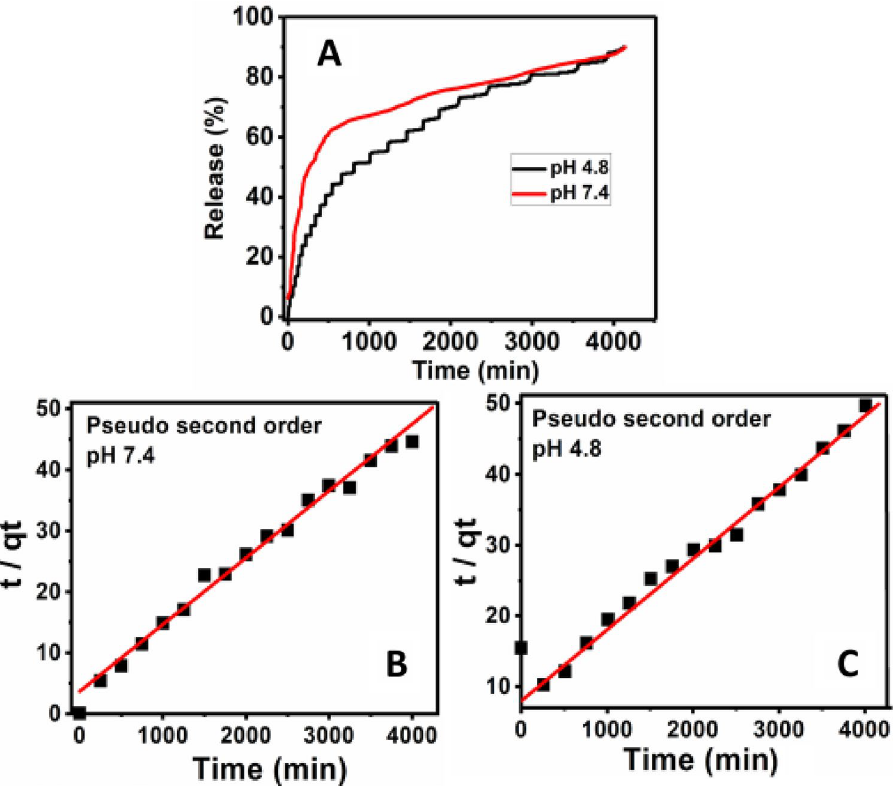
Figure 4. In vitro release of PZA and its kinetic fitting for the pseudo-second-order model; ( A ) the in vitro release of PZA from PZA-MgLH nanocomposites in PBS solutions of pH 7.4 and pH 4.8, kinetic fitting of PZA in vitro release in pseudo-second-order model at pH 7.4 ( B ) and 4.8 ( C ).